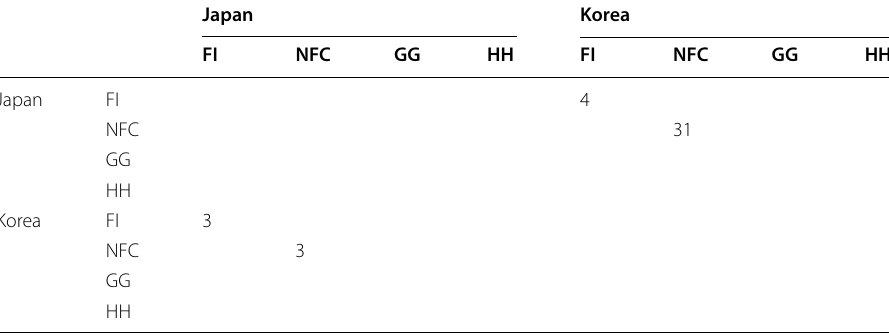
Table 16 Incorporation of CDIS data for Japan and IBS into the International FIO Framework (in units of 1 billion